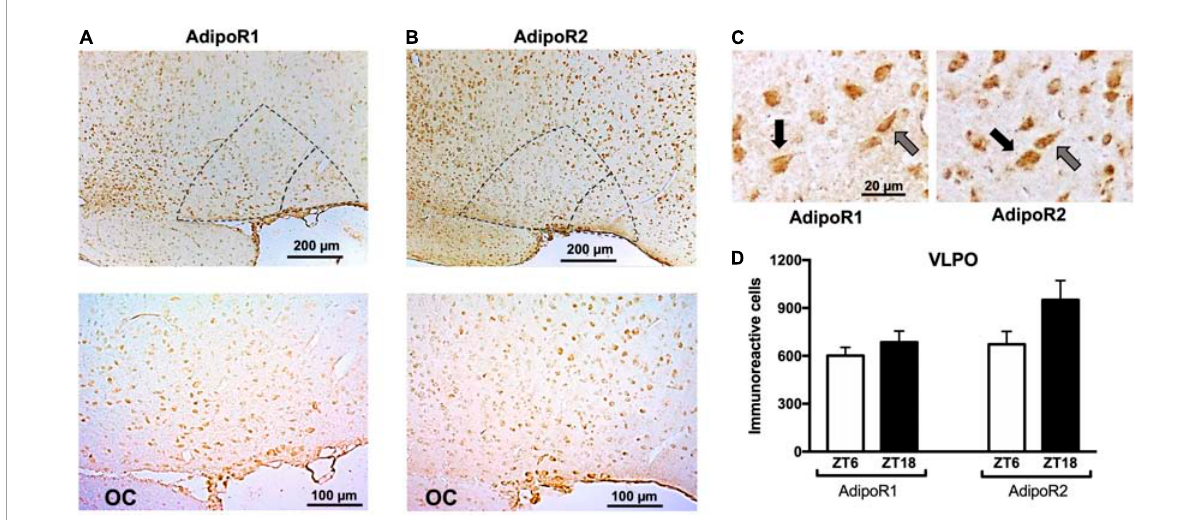
FIGURE3 Immunoreactivity of adiponectin receptors in the VLPO. Representative immunoreactivity of (A) AdipoR1 or (B) AdipoR2 at 10 × (upper) and 20 × magnification (lower). In both cases, core VLPO is observed in the inner dotted triangle, and the bigger triangle represents the extended VLPO. (C) Pyramidal (black arrows) and fusiform (gray arrows) morphology were observed in AdipoR1 and AdipoR2. (D) AdipoR1 or AdipoR2 immunoreactivity positive cells at ZT6 or ZT18. VLPO, ventrolateral preoptic nucleus; OC, optic chiasm.